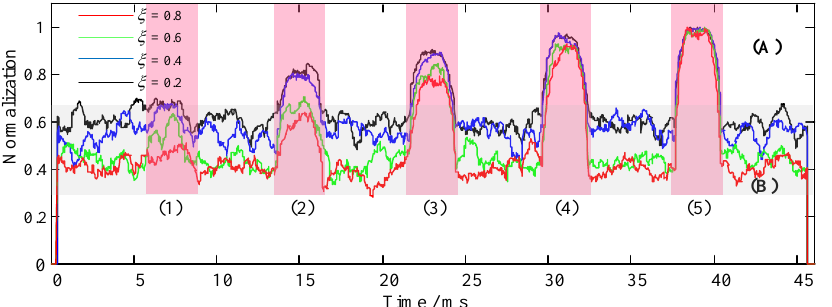
Figure 6. Recognition performance analysis with recognition coefficient ξ , where λ = 2. ( A ) Simulated target signal identification area. ( B ) Noise suppression area. ( 1 – 5 ) The SRCs of the simulated target signals with different energy ratios.